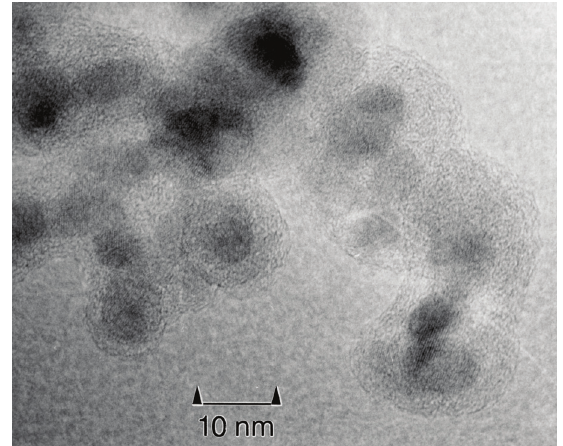
O /polymer core/shell 2 3